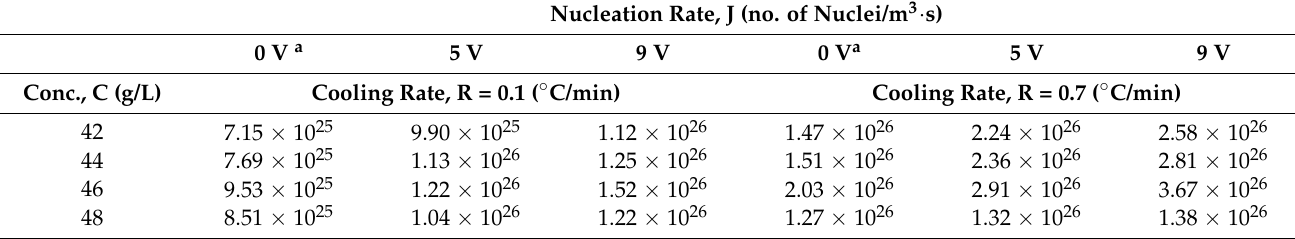
Table 2. Nucleation rate of L-isoleucine from polythermal crystallisation, calculated using Equation (9) in Supplementary Materials, Section S2 for a system without electric potential (0 V) and a solution with electric potential. Nucleation Rate, J (no. of Nuclei/m 3 ·